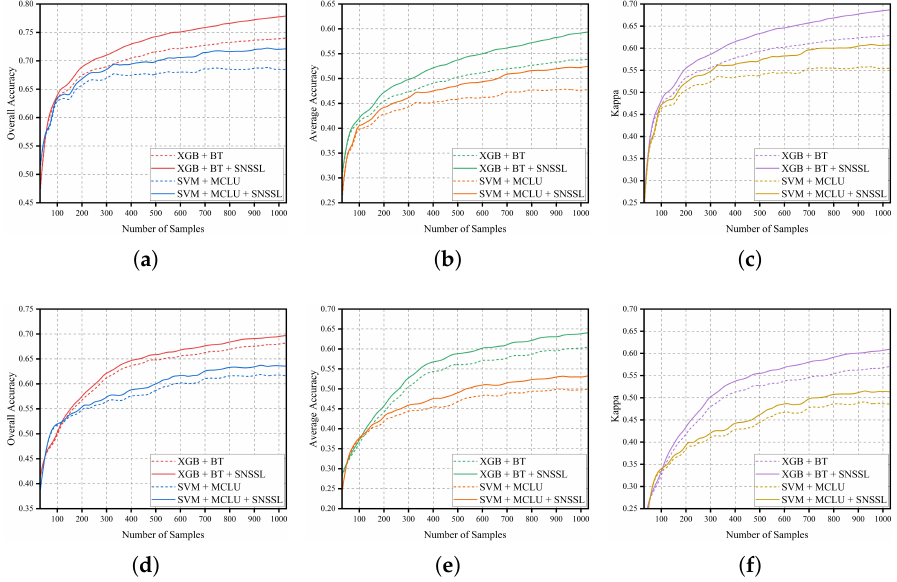
Figure 11. Training curves of Potsdam images: ( a ) OA of 2_10; ( b ) AA of 2_10; ( c ) Kappa of 2_10; ( d ) OA of 3_10; ( e ) AA of 3_10; ( f ) Kappa of